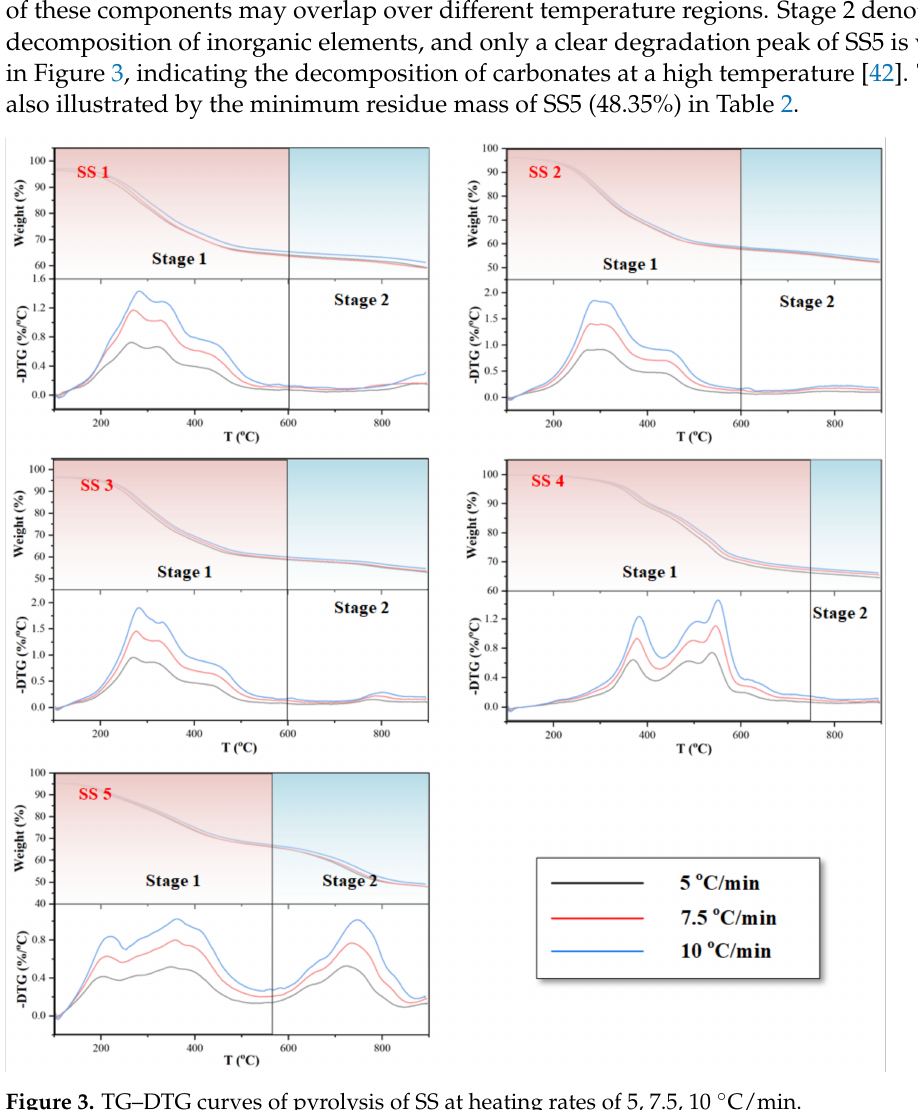
Figure 3. TG–DTG curves of pyrolysis of SS at heating rates of 5, 7.5, 10 ◦